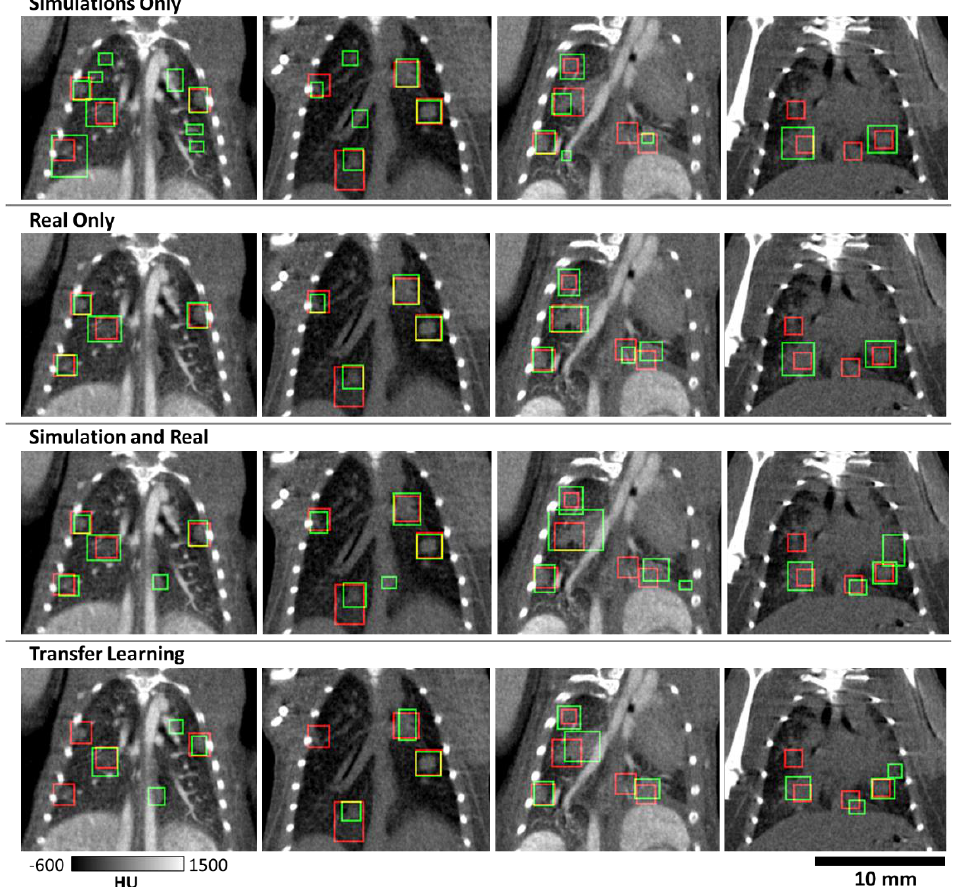
Figure 7. Samples showing bounding boxes for hand-curated labels (red) and predicted tumors (green) marked by bounding boxes. Four mice are shown as columns, showing performance with and without the addition of contrast. Though there is variation in network predictions, detection performance is largely similar between training cases. A major source of error is the similarity of vasculature and nodules in these images. Using the decision threshold calculated via the precision and recall curves, all real data were run through their related K-fold networks and detections were calculated. This resulted in the whole dataset being processed as test data. The aggregate detection per- formance for each training strategy is summarized in Table 1. This table lists the number of true positives, false positives, and false negatives for the entire real dataset. These val- ues are used to calculate precision, recall, and Dice scores using equations 2 – 4 for each training strategy. These data show that using only simulations provides the most similar precision and recall metrics, with an overall performance which is slightly better than us- ing real data alone (Dice of 0.643 vs 0.623). Training using only real data results in a large number of false positives compared to other strategies, negatively impacting its precision. Using both simulated and real data, with joint training or transfer learning, provides the best performance according to the Dice scores (0.661 and 0.665, respectively). Additionally, precision on average increased 8% against networks trained on one type of data. This in- dicates that the increased number of training sets improves performance. Transfer learn- ing has the highest overall Dice score; however, higher sensitivity as seen with joint train- ing may be preferable for detection tasks so that nodules are not missed.